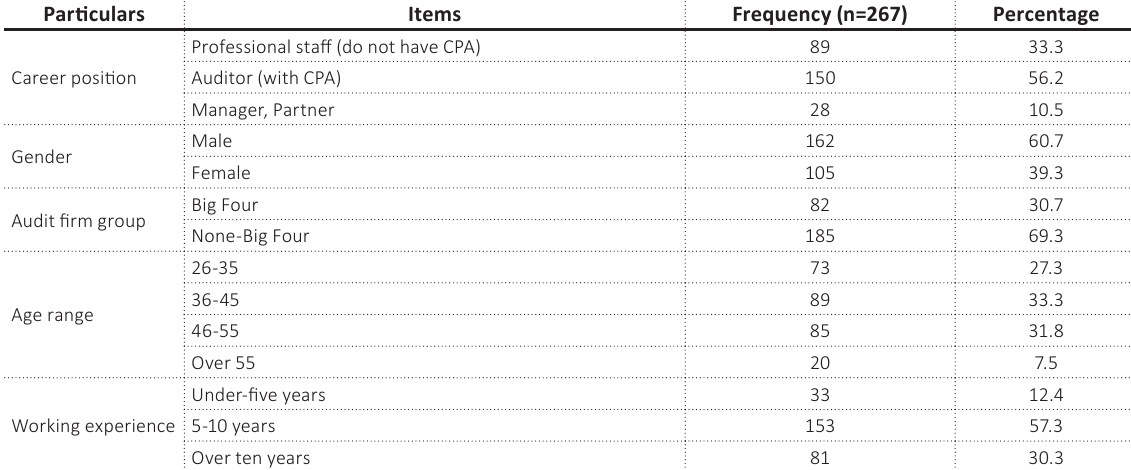
Table 1. Characteristics of the research data sample Particulars